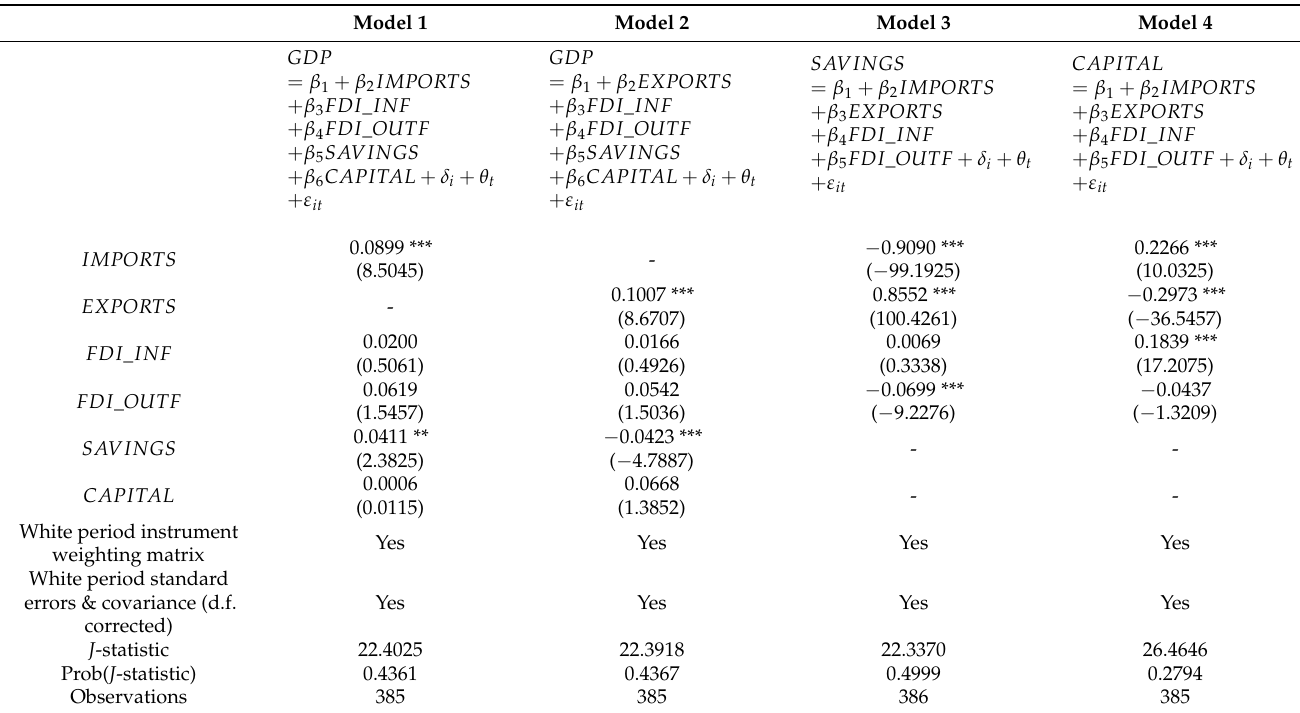
Table 6. Econometric models with the GMM